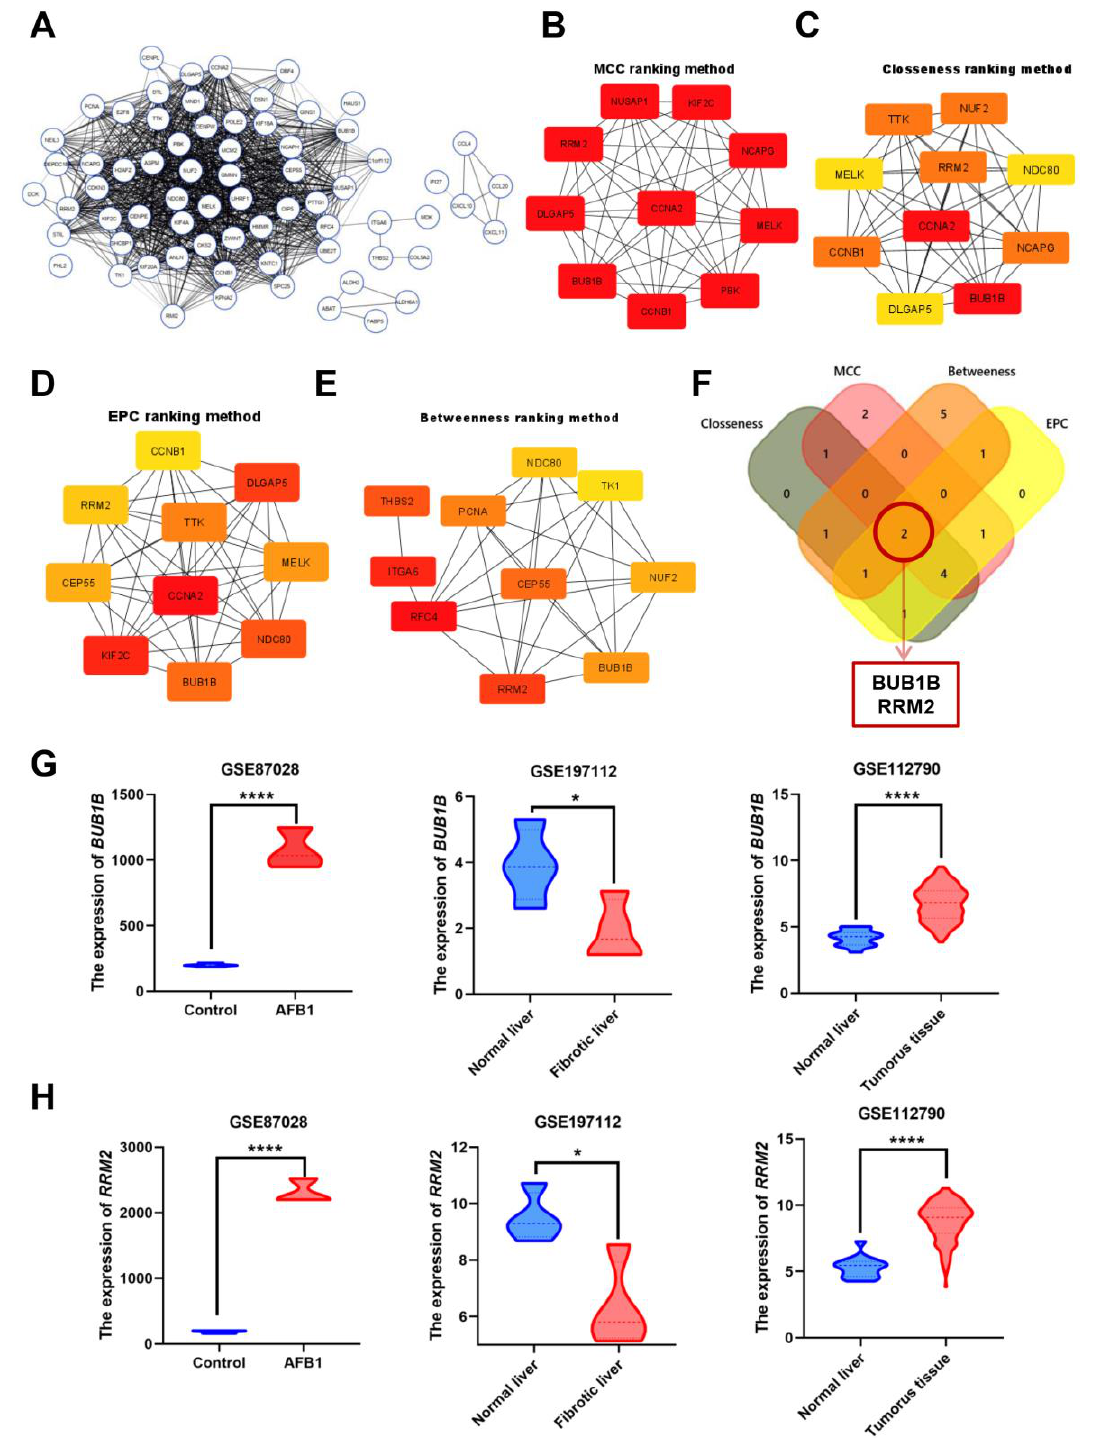
Figure 2. Identification of Hub genes in overlapping DEGs among three GEO datasets. ( A ) Protein- protein interaction of the overlapping DEGs. ( B – E ) Maximal clique centrality (MCC) ranking method, closeness ranking method, edge percolated component (EPC) ranking method, and betweenness ranking method for hub genes identification. ( F ) Venn diagram for identifying hub genes among different ranking methods. ( G ) The expression of BUB1B in three GEO datasets. ( H ) The expression of RRM2 in three GEO datasets. Red color represents highest degree, and orange color represents intermedia degree, and yellow color represents lowest degree. * p < 0.05; **** p < 0.0001.